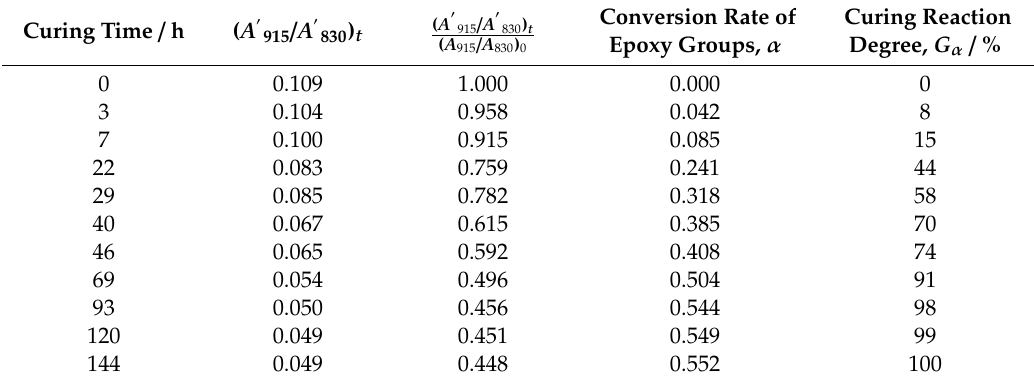
Table 4. Calculated conversion rate of epoxy groups, α , and the curing reaction degree of epoxy asphalt, G α